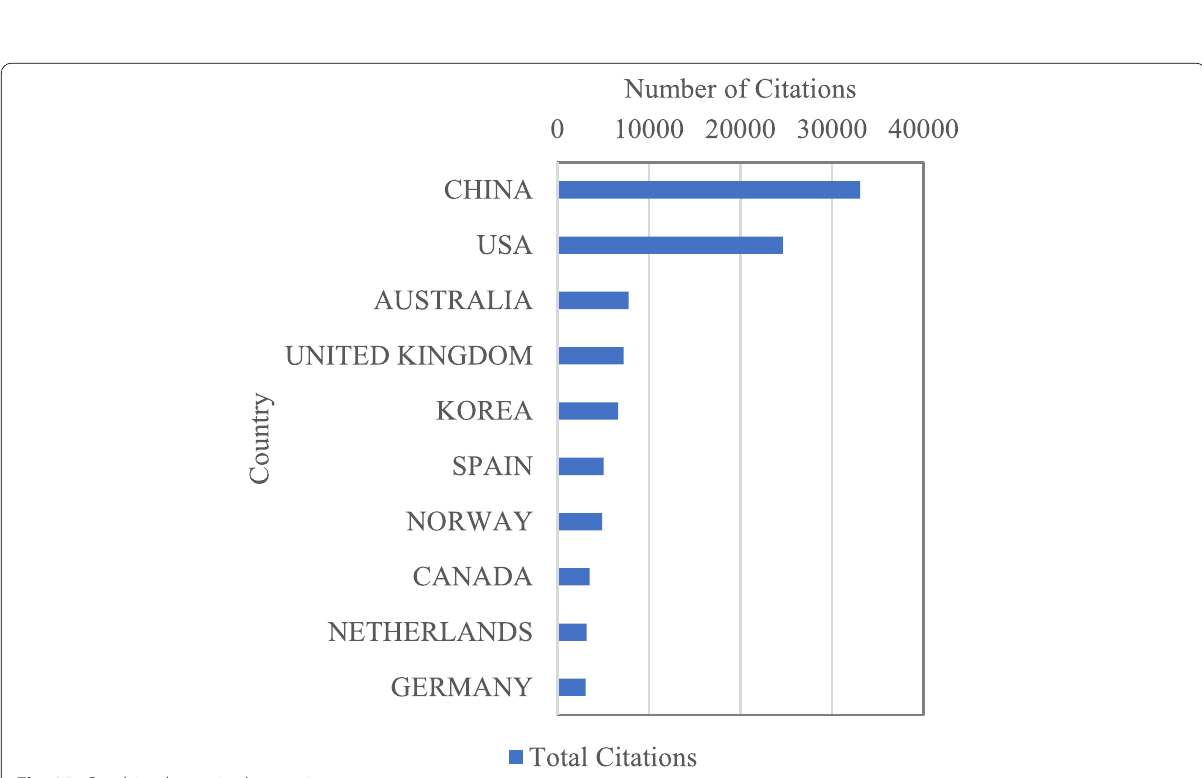
Fig. 28 Combined, top cited